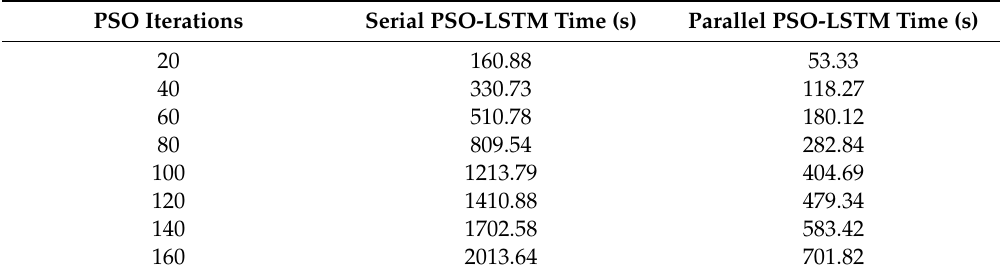
Table 6. Time consumption comparison of parallel and serial PSO-LSTM implementations.